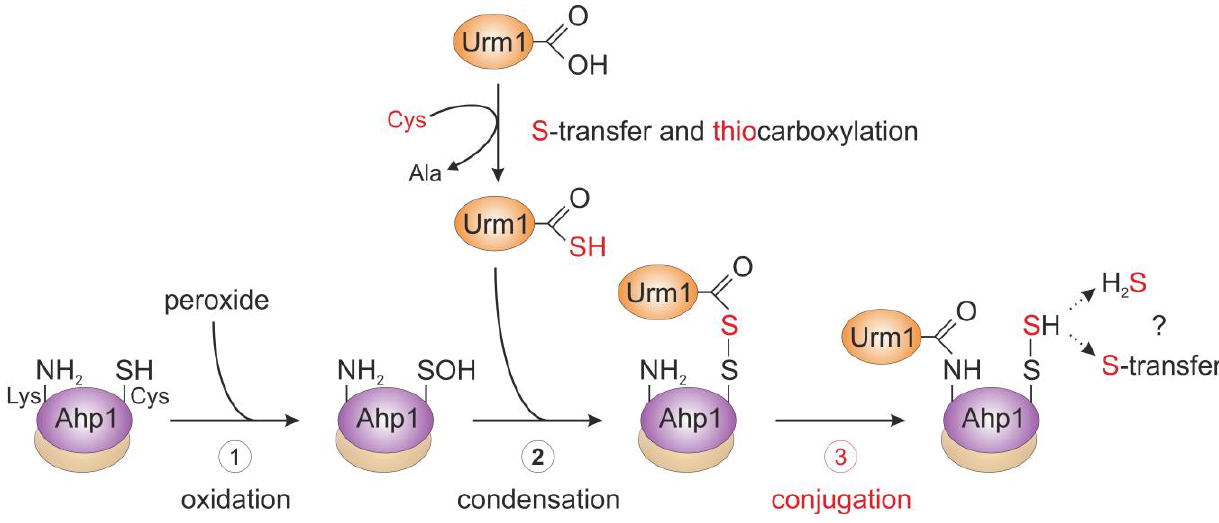
FIGURE 3: Working model for urmylation of the peroxiredoxin Ahp1. Step 1 (oxidation): the thiol of the peroxidatic cysteine (Ahp1-SH) is oxidized by the reaction with a peroxide to form the sulfenic acid (Ahp1-SOH) that becomes surface exposed and accessible for the reaction with Urm1. Step 2 (condensation): sulfur mobilization from cysteine and S-transfer to Urm1 yields the activated Urm1 thiocarboxylate (Urm1-COSH). This condenses with the sulfenic acid to form an acyl disulfide (Ahp1-S-S- Urm1). Step 3 (conjugation): the ε -amino group of a nearby lysine residue in Ahp1 (Ahp1-NH 2 ) mounts a nucleophilic attack on the Urm1 carbonyl group, generating an iso-peptide bond with Urm1 (Ahp1-NH-CO-Urm1) and a persulfide on the peroxidatic cysteine (Ahp1-S-SH). Possibly, Ahp1 transfers the persulfide to other pro- teins or releases hydrogen sulfide (H 2 S). The lysine-directed urmylation might support the S-transfer by sterically preventing the latter op- tion. For simplicity, the illustration solely involves one subunit of the Ahp1 homodimer. Partial reaction steps in need of further verification are marked in red (step 3), while those supported by experimental evidence (step 1 and 2) are labeled